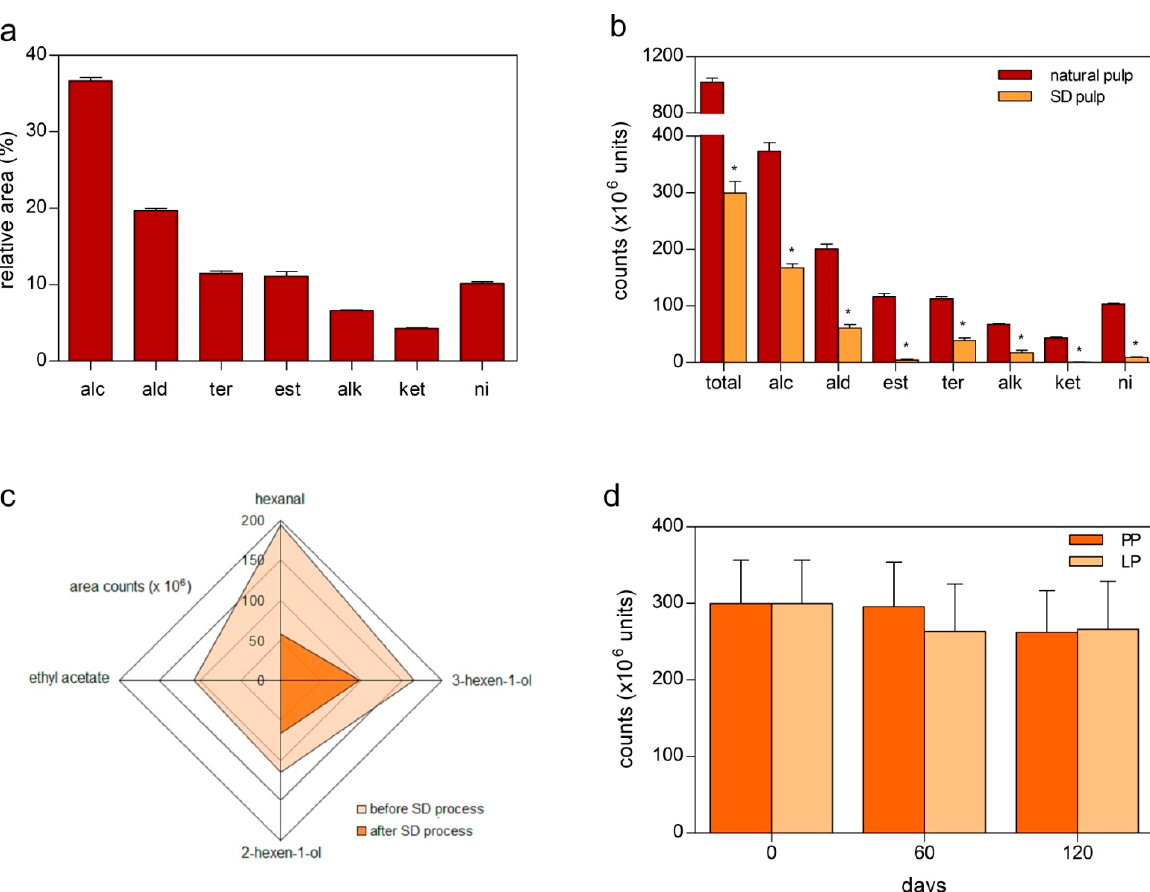
Figure 1. ( a ) Relative chromatogram area of alcohols (alc), aldehydes (ald), terpenes (ter), esters (est), alkanes (alk), ketones (ket) and non-identified (ni) compounds in red mombin pulp; ( b ) chromatogram area of red mombin pulp before and after the spray-drying (SD) process; ( c ) chromatogram area of the majority of compounds of the red mombin pulp before and after the SD process; ( d ) chromatogram area of volatile compounds of the powder of red mombin pulp during storage with plastic (PP) or laminated package